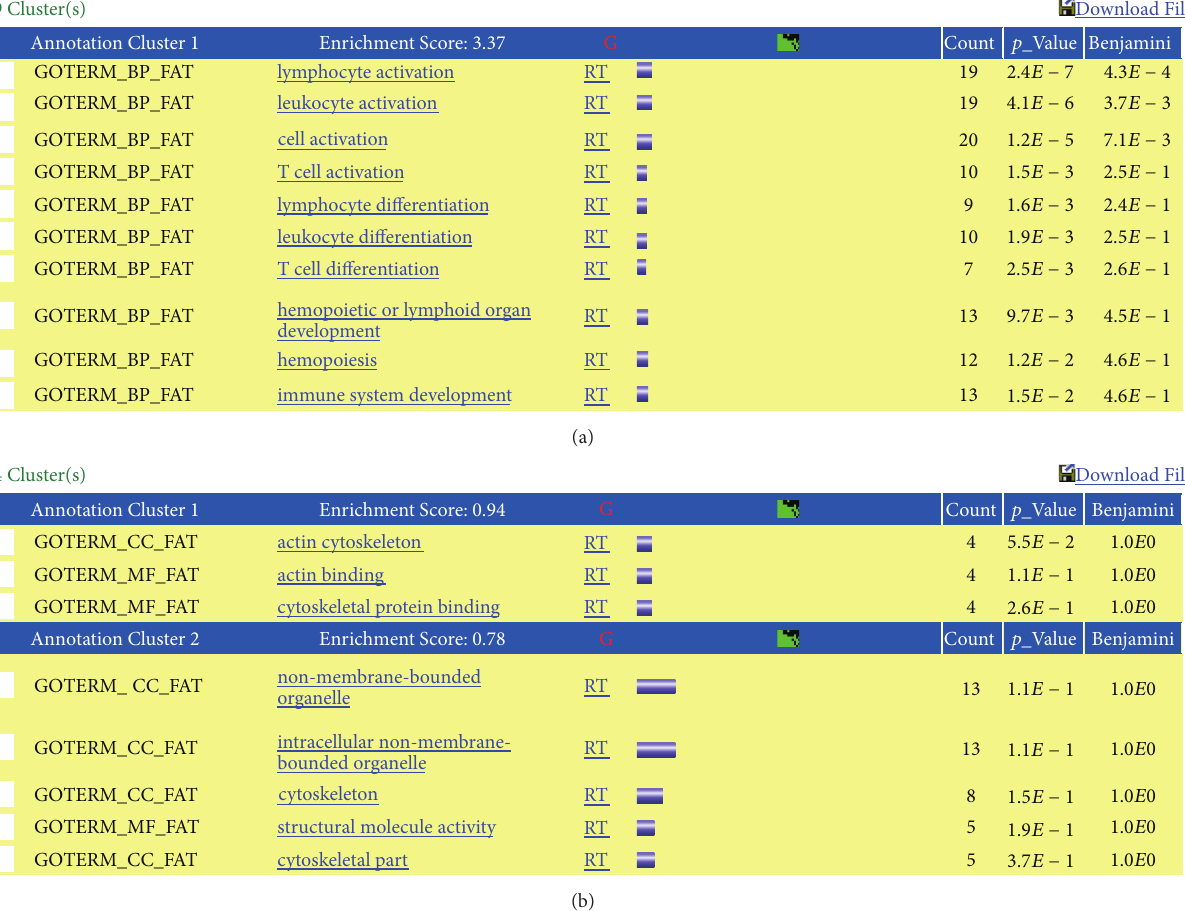
Figure 2: The expression ratio (ratio of the mean in the IPH group to the mean in the healthy control group) was calculated for each gene. Results of functional annotation clustering analysis are given for (a) the group showing significantly reduced expression among patients with IPH (Group C: healthy control/IPH > 1.5, 𝑝 < 0.1 ) and (b) the group showing significantly increased expression among patients with IPH (Group D: IPH/healthy control > 1.5, 𝑝 < 0.1 ). (a) Group C had the highest enrichment score (3.37), and its cluster included many gene terms related to the immune system, such as “lymphocyte activation” and “leukocyte activation.” (b) In Group D, the enrichment score was low (0.94), and no gene function terms were found to be specifically increased in the presence of